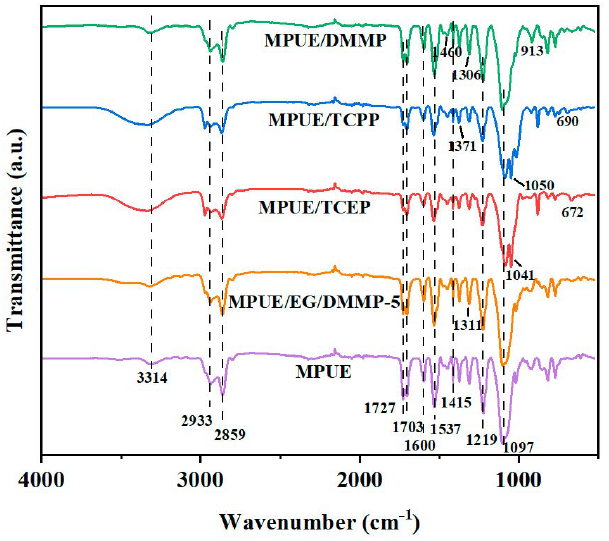
Figure 3. FTIR spectra of MPUE, MPUE/TCEP, MPUE/TCPP, MPUE/DMMP, and MPUE/EG/DMMP-5.